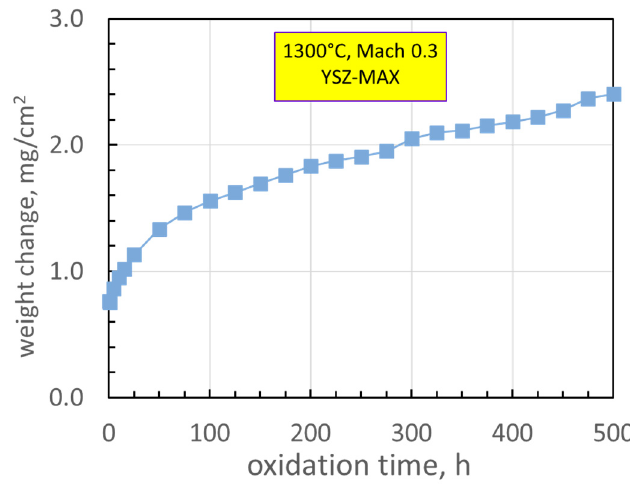
Figure 1. Weight change performance of YSZ-coated Ti 2 AlC MAX phase in 1300 °C Mach 0.3 burner test. (from Smialek et al., 2020 [5]).